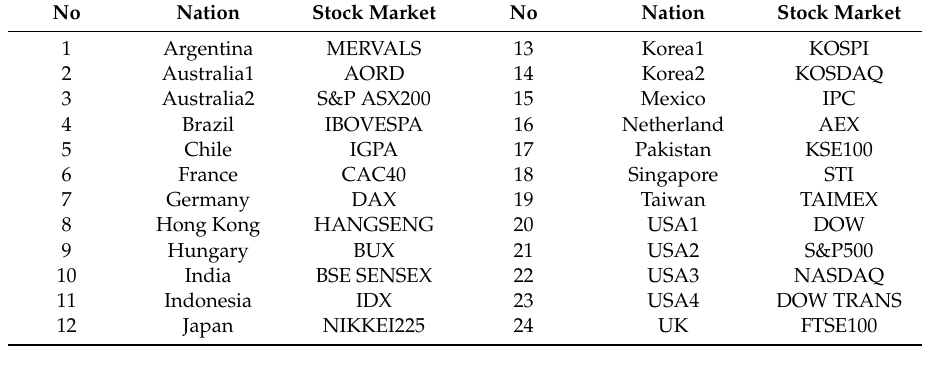
Table 1. Surveyed global 24 stock market lists.